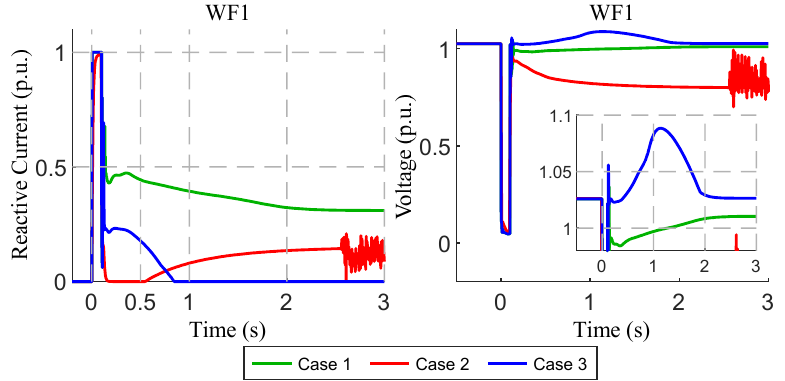
Figure 35. WF1 reactive current output and terminal voltage.